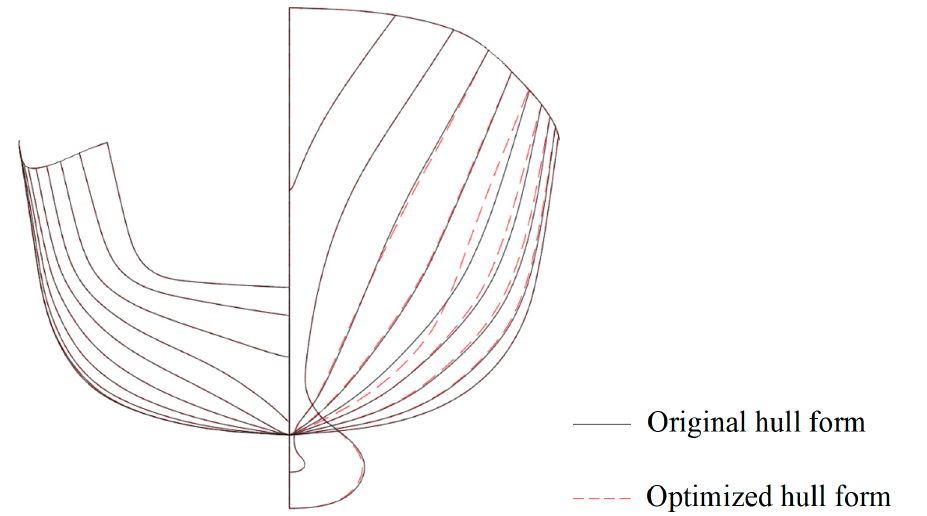
Figure 15. Optimization convergence curve of direct optimization.